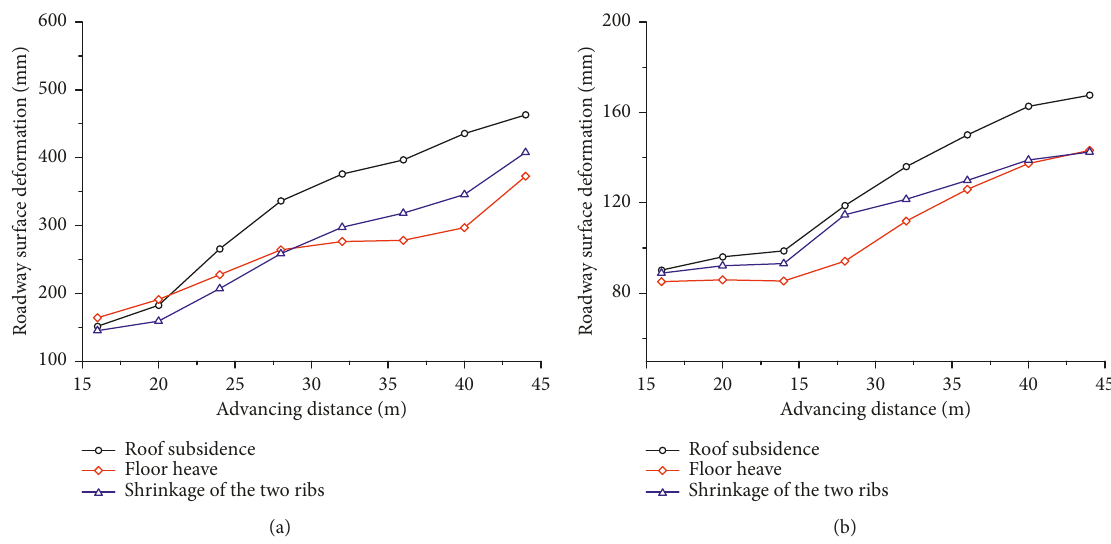
Figure 8: The maximum displacement’s change of the roadway surface with the progress of the working face excavation: (a) shed supporting and (b) bolt-grouting supporting.